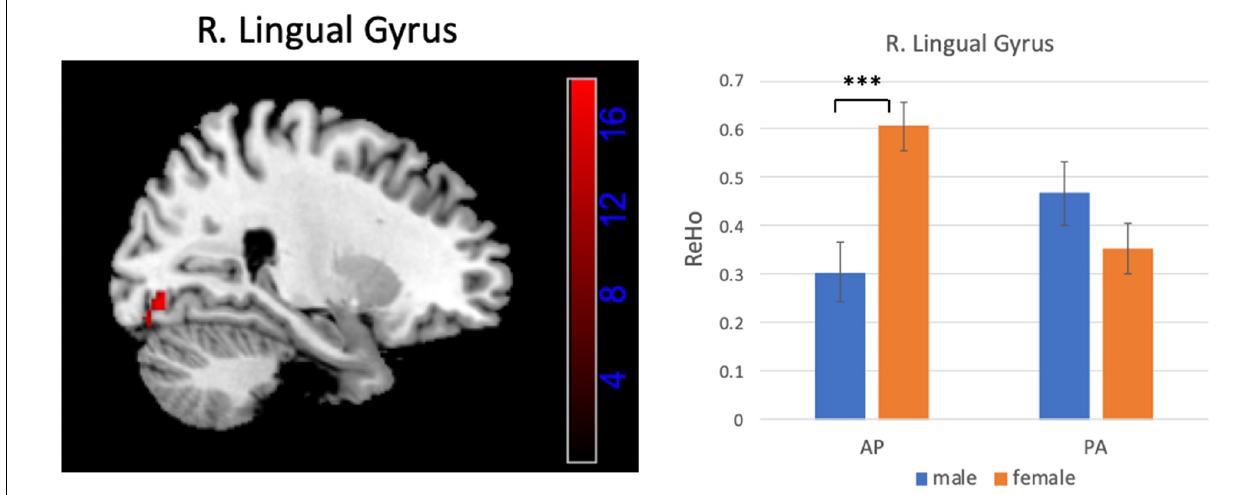
FIGURE 7 | Brain region influenced by the interaction effect between gender and PE direction (AP vs. PA) for ReHo and the result of post hoc analysis. ∗∗∗ p < 0.001. TABLE 5 | Regions influenced by the interaction effect between gender and PE direction (LR vs. RL) for each index in the HCP data. Brain region Hemisphere BA MNI coordinates Peak T value Cluster